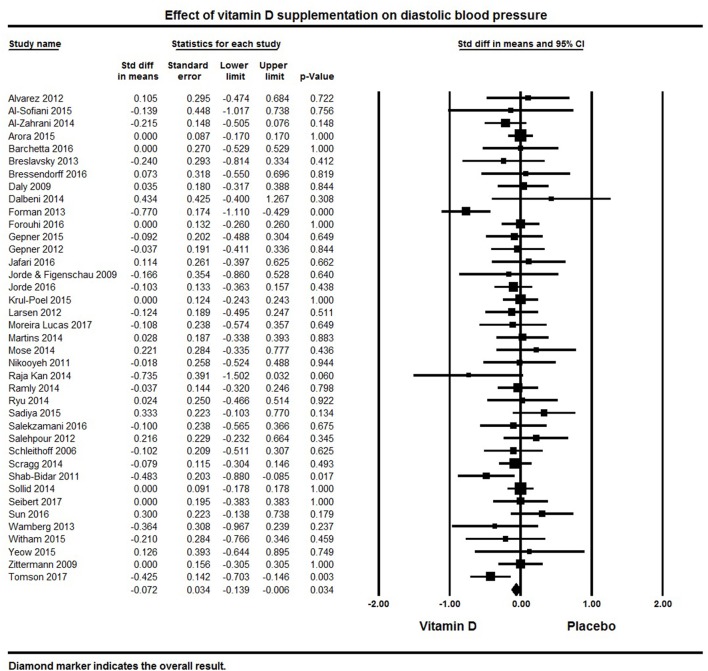
Forest plot detailing standardized mean difference for the impact of vitamin D on diastolic blood pressure.